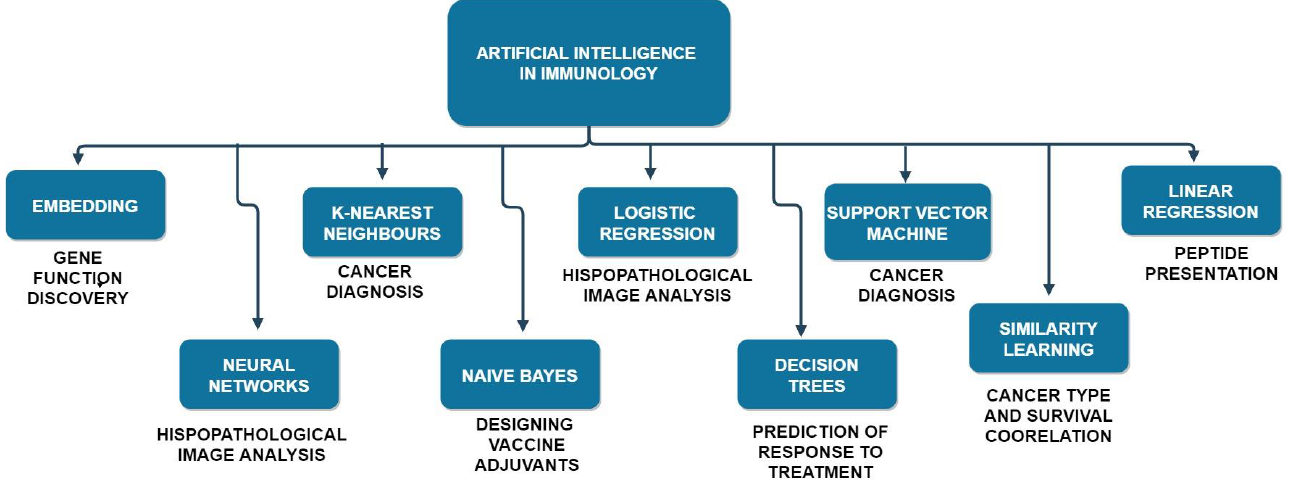
Figure 12. A hierarchical representation of common machine and deep learning methodologies applied to immunology.